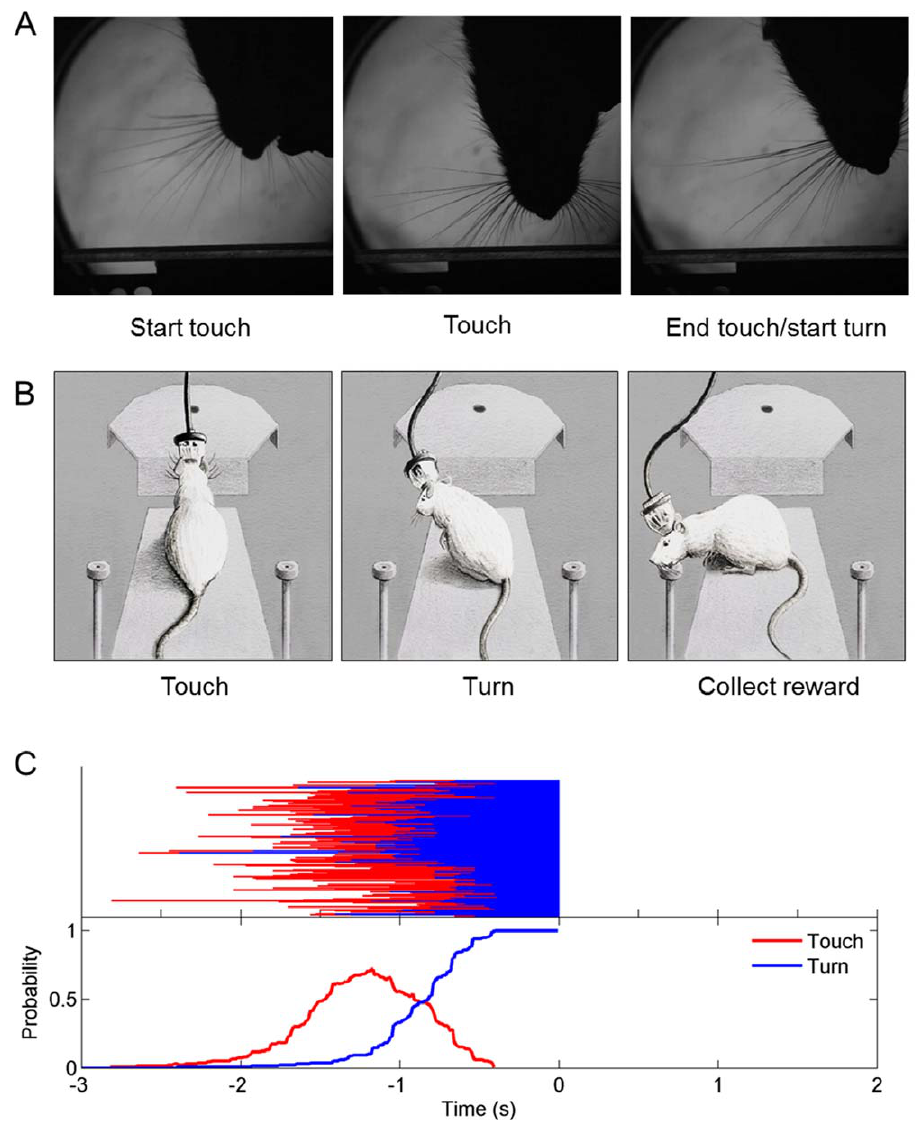
Figure 2. Time course of behavior. (A) Images from overhead high-speed video illustrating the initial contact (left), palpation of the texture (middle) and the instant of withdrawal (right), equivalent to the beginning of the turn. (B) On each trial the rat approached the plate, triggering an optic sensory, and touched the texture with its whiskers (left). Once the animal identified the texture, it turned to the right or to the left drinking spout (middle) where it collected the water reward (right). (C) Time course of behavior in a typical recording session. Upper plot: for all the trials, horizontal red lines indicate the duration of touch time and blue lines indicate turn time. Trials are aligned on reward onset, 0 ms. Lower plot: By summating over trials, we calculated the probability that the rat was engaged in touch (red) or turn (blue) at any given